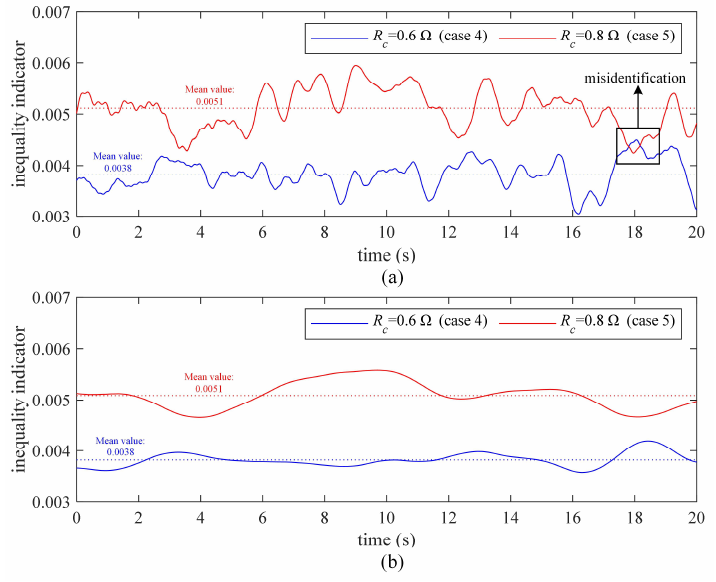
Figure 5. The inequality indicator with different w f , ( a ) w f = 1000, ( b ) w f = 4000.